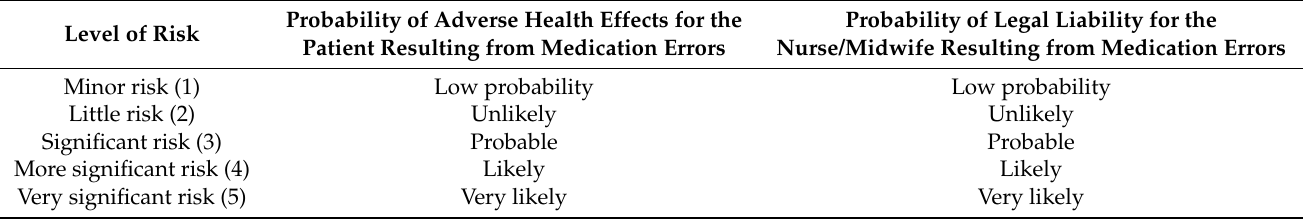
Table 1. Linking risk levels in the pharmacotherapy process to negative health consequences for the patient and the legal responsibility of nurses and